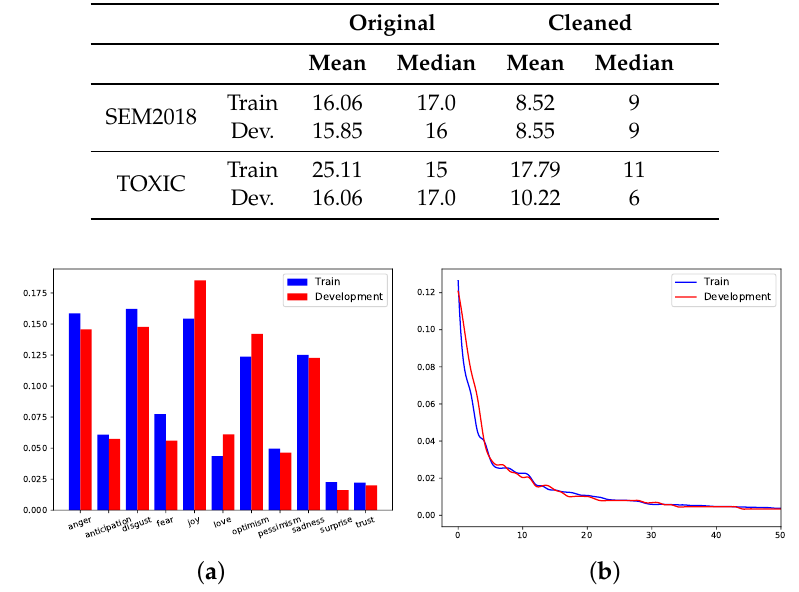
Table 1. Sentence length.